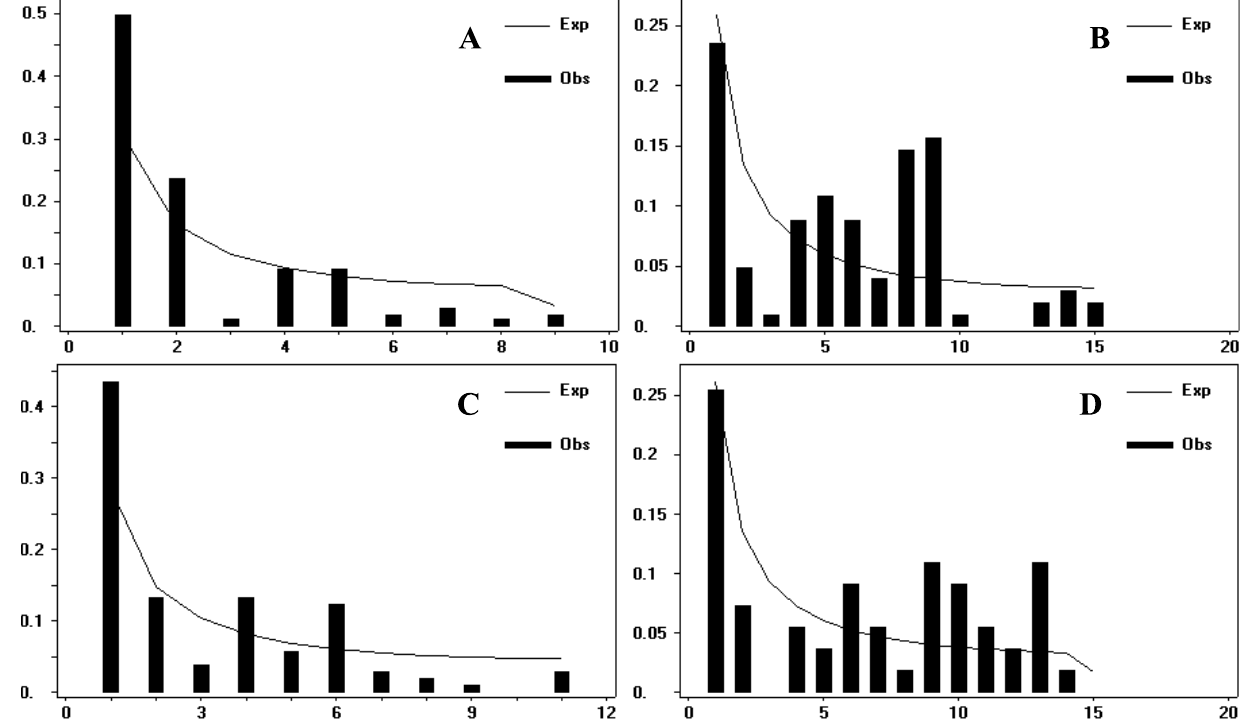
Figure 4. Allelic frequency of the Waxy and Adh 1 genes. (A) Waxy gene for all M. acuminata accessions ; B: Waxy gene for the A genome of cultivated banana; C: Adh 1 gene ( M. acuminata ); D: Adh 1 gene (cultivated banana).